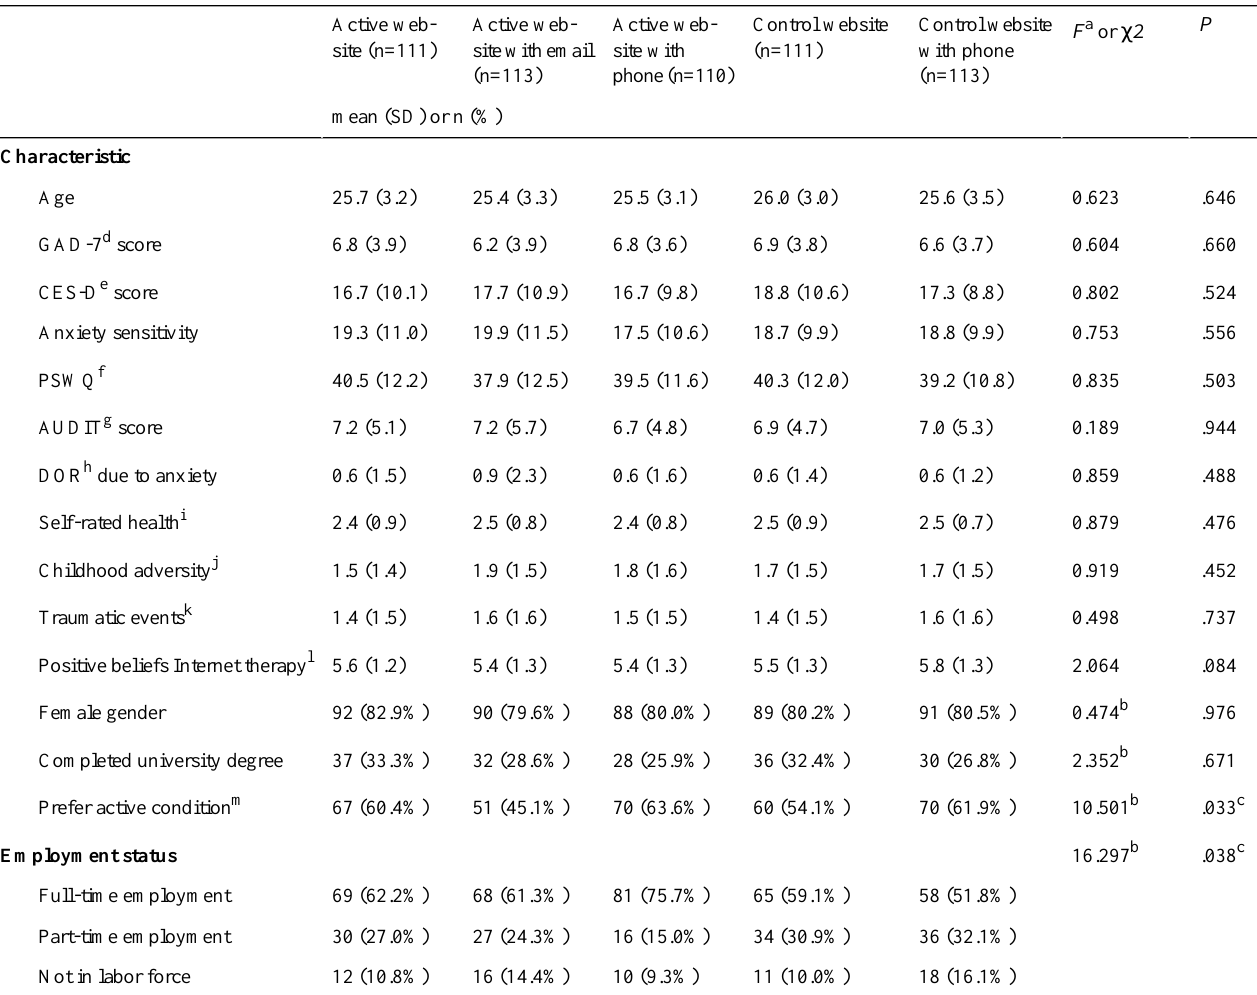
Table 1. Characteristics of the sample at baseline by trial